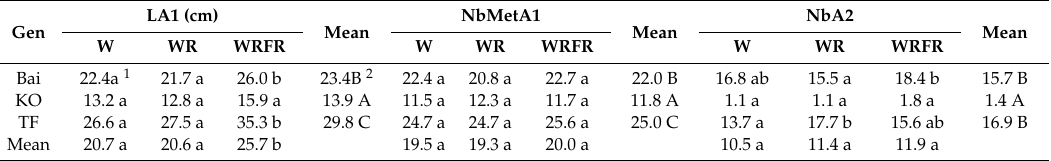
Table 4. Least-square means (LS means) of elongation and branching variables measured on the order 1 axis at measurement point 1 for Baipome (Bai), Knock Out ® Radrazz (KO) and ‘The Fairy’ (TF) grown in a climatic chamber under three light conditions: W, WR, and